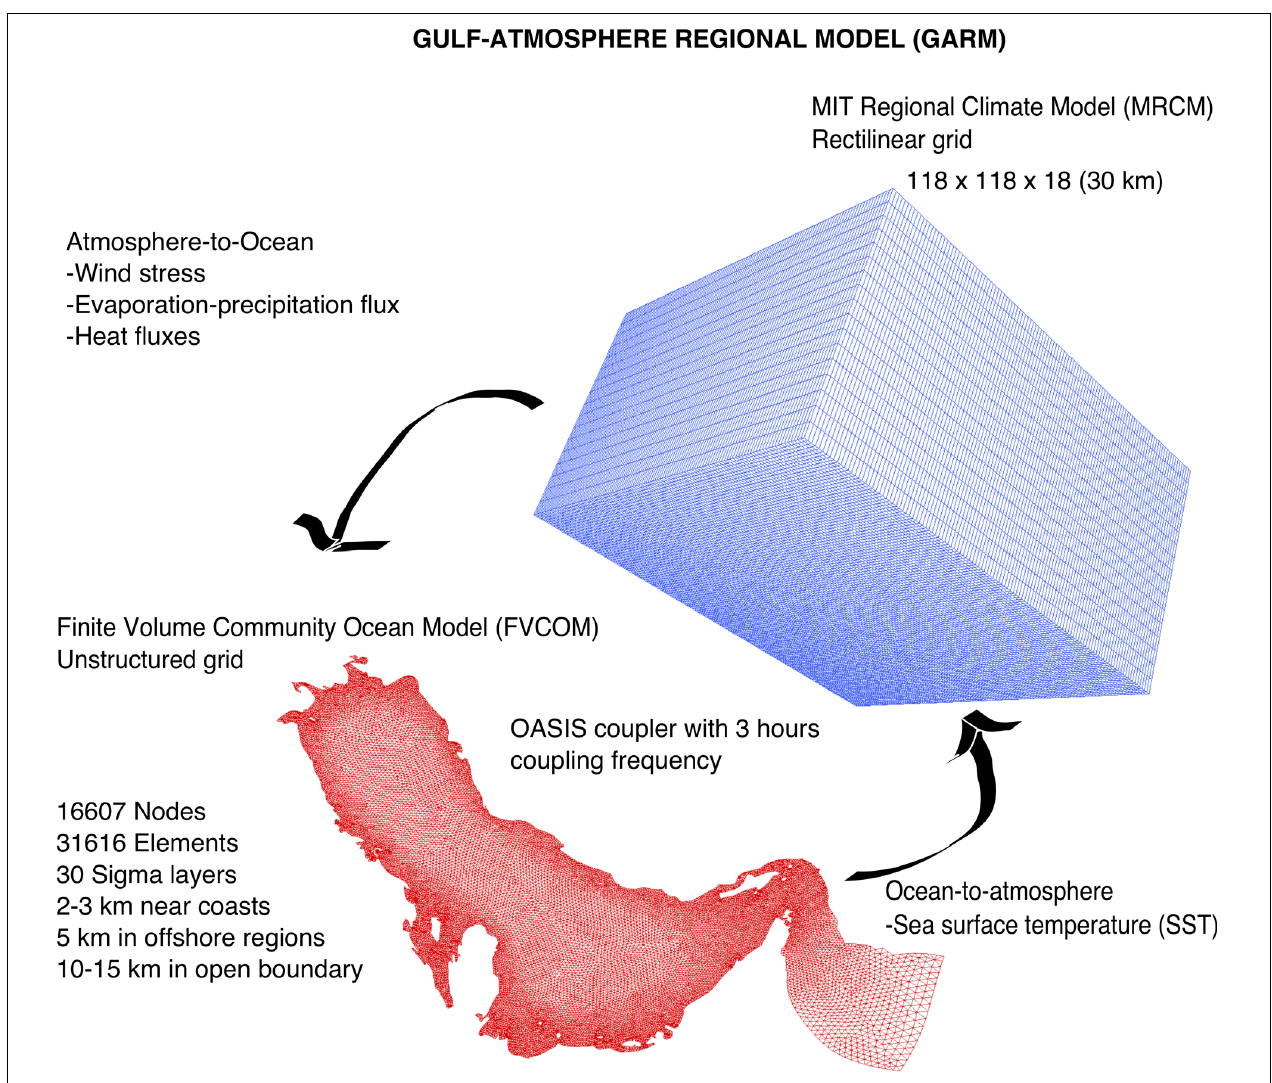
FIGURE 2 | Configuration of Gulf–Atmosphere Regional Model